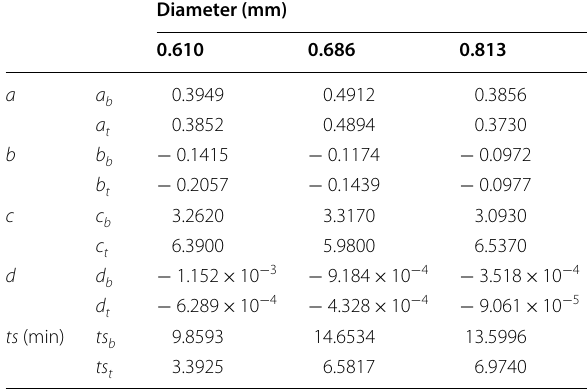
Subscripts t and b represent top and bottom, respectively ts represents the time at which T 1 decreases to 3% of T 2 , which indicates that the influence of T 1 can be ignored